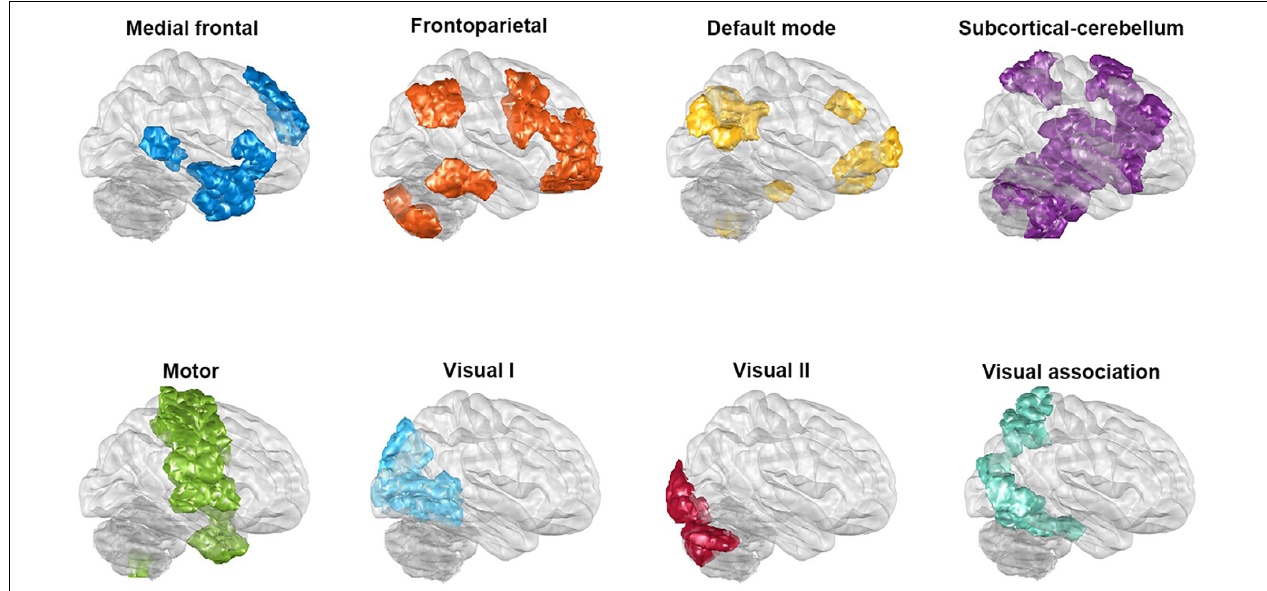
FIGURE 1 | The regions of the eight networks obtained from Shen’s whole-brain functional-connectivity-based atlas. The networks consist of the medial frontal network, the frontoparietal network, the default mode network, the subcortical and cerebellar regions, the motor network, the visual I network, the visual II network, and the visual association network. The glass brains in this figure are shown from a lateral view of the right